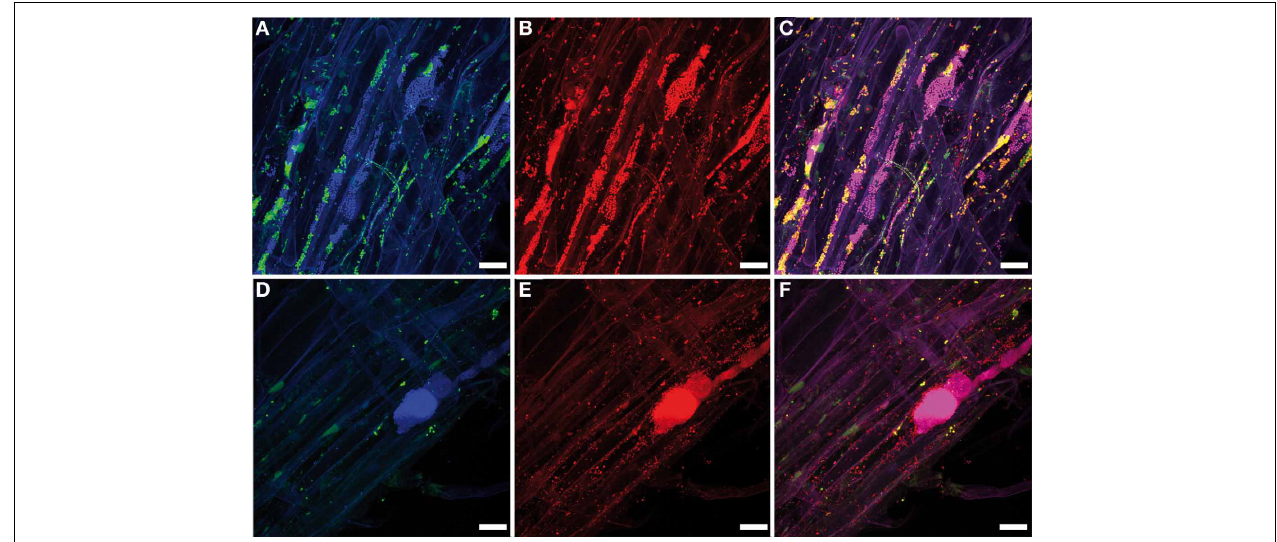
FIGURE 3 | Microbial interactions in the rhizosphere. Maximum projections of a confocal stack showing the colonization pattern of salad root ( Lactuca sativa ) by the native bacterial community stained by FISH. (A,D) Gammaproteobacterial and betaproteobacterial cells (green and blue, respectively) stained with the FISH probes Gam42a (Cy5-labeled) and Bet42a (ATTO488-labeled), respectively. (B,E) All bacterial cells (red) stained with the FISH probe EUB338-MIX (Cy3-labeled). (C,F) Overlap of images (A,B,D,E) , respectively; yellow, Gammaproteobacteria; pink, Betaproteobacteria; red: other bacteria. Different taxa do not share the